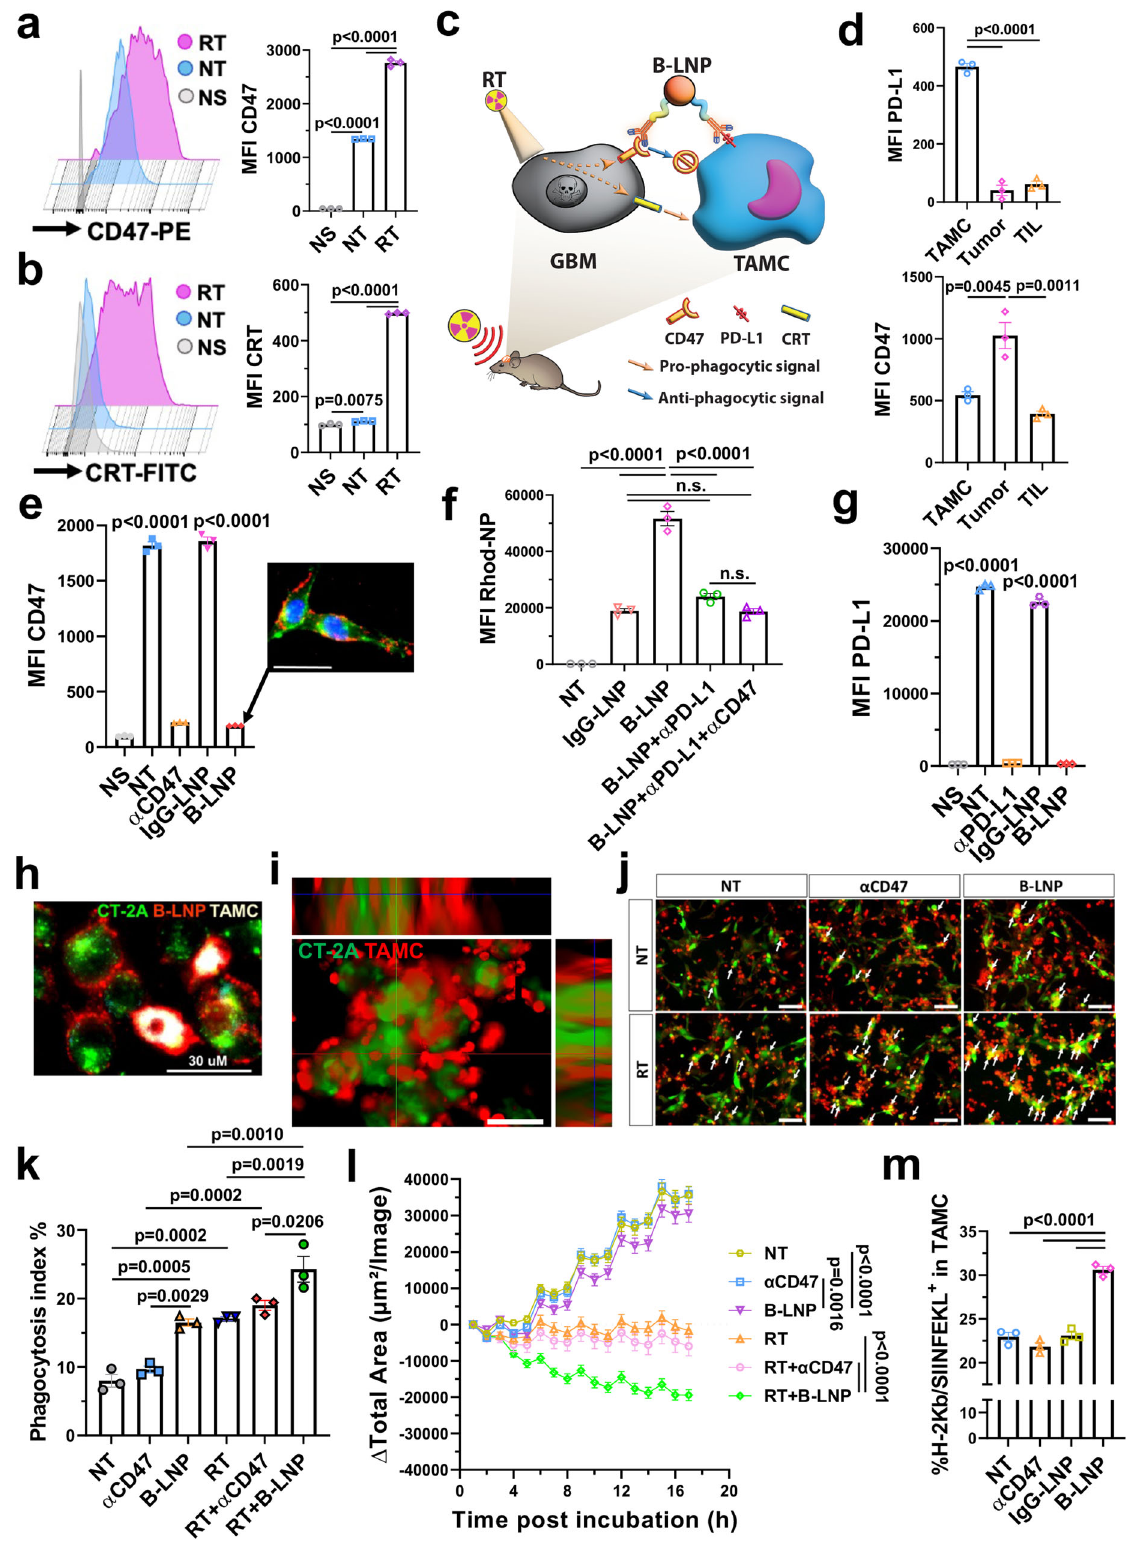
(Fig. 2g, Supplementary Fig. 1e). B-LNPs demonstrated similar binding kinetics to both TAMCs and gliomas (Supplementary Fig. 3b), and the cellularbindingofB-LNPspromptlyinducedTAMC-gliomacouplingas revealed by fl uorescence microscopy (Fig. 2h ) and Z-stack imaging ( Supplementary Fig. 4). The ability of B-LNP to form TAMC-glioma cell clusters was also observed using Z-stack imaging through the